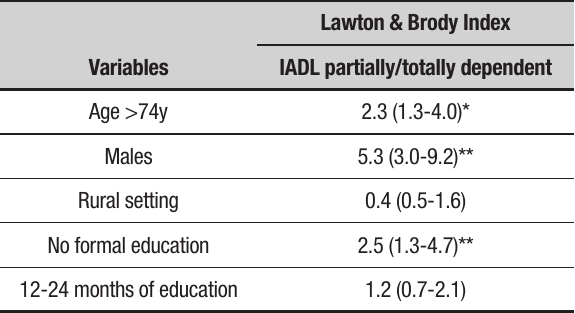
Table 3. Factors (age, sex, setting and level of formal education) associ- ated with being categorized as totally dependent for IADLs and partially dependent (Lawton & Brody Index) Odds ratio, 95% confidence intervals in brackets.